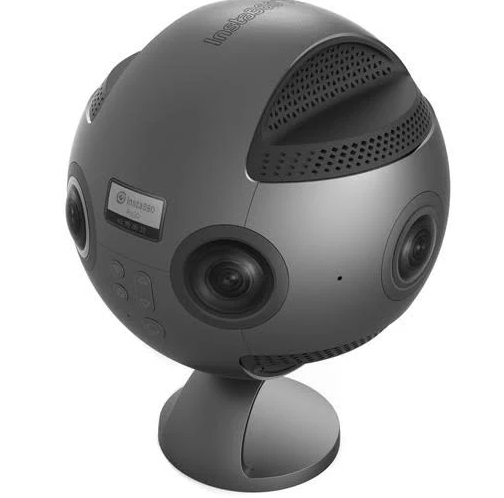
Figure 1. Insta360Pro system.